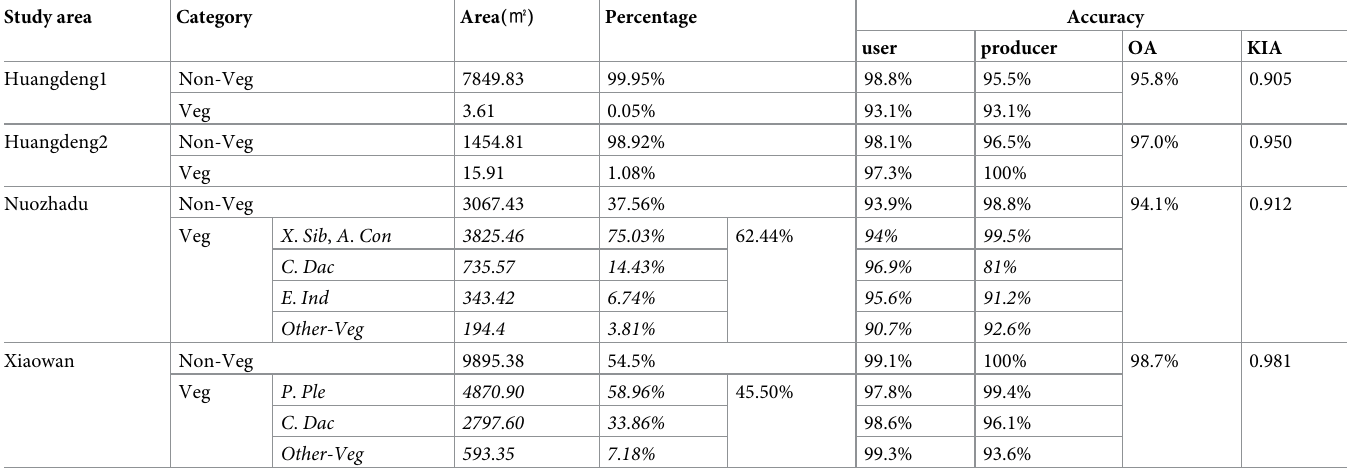
Table 2. Vegetation area, percentage and classification accuracy of WLFZs in each study